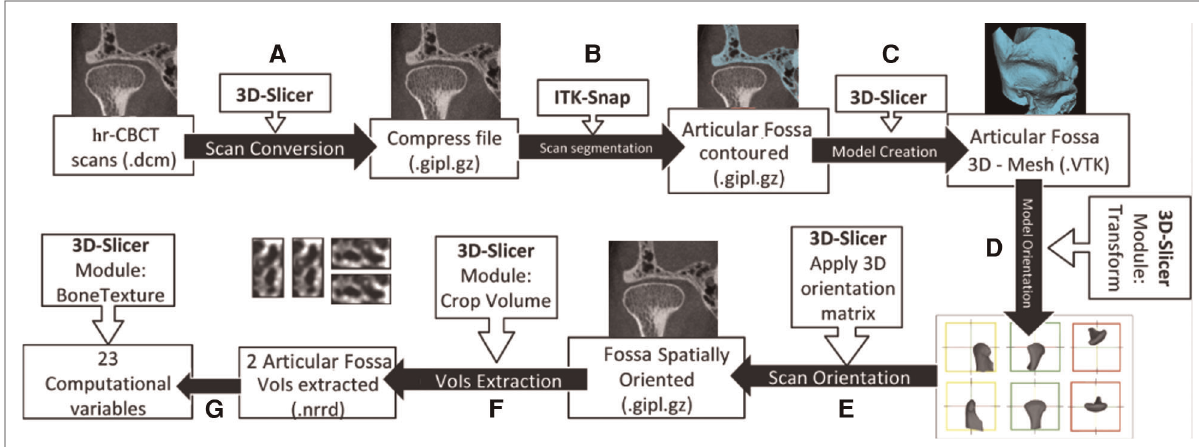
FIGURE 1 Image processing work fl ow adapted from bianchi et al. (2021) using 3D Slicer and ITK-SNAP open source software. ( A ) hr-CBCT fi les were anonymized and compressed. ( B ) The condyle and articular fossa were segmented. ( C ) 3D Slicer was used to convert the segmented articular fossa volume to a 3D surface. ( D ) Using the “ transform ” module, a standardized spatial orientation for each 3D TMJ bones model was made. Left TMJ scans were mirrored to the right side. ( E ) The spatial orientation matrix created in the last step was applied to the TMJ scan. ( F ) Using the “ crop-volume ” tool, two regions of the articular fossa (anterolateral, and articular eminence) were selected. ( G ) Using the “ BoneTexture ” module, all of the radiomic variables were computed.